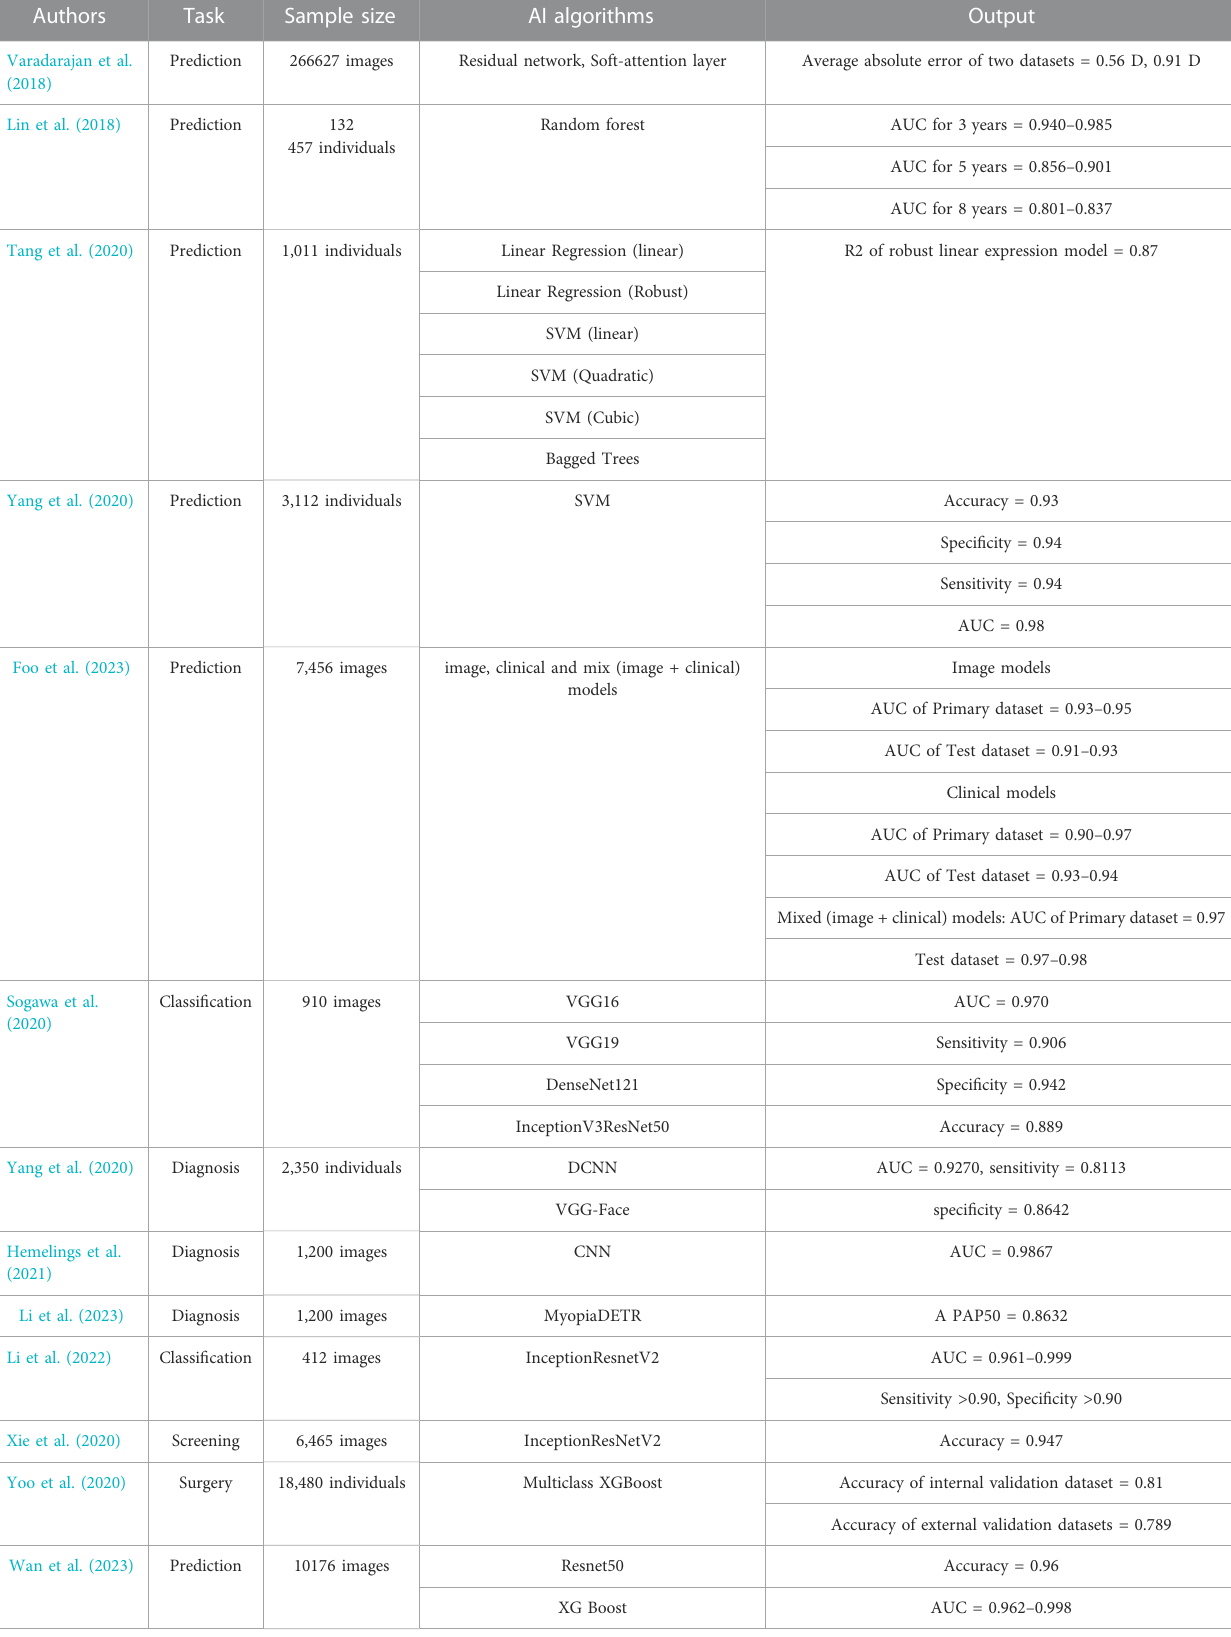
TABLE 1 Application summary of different AI models and algorithms used in